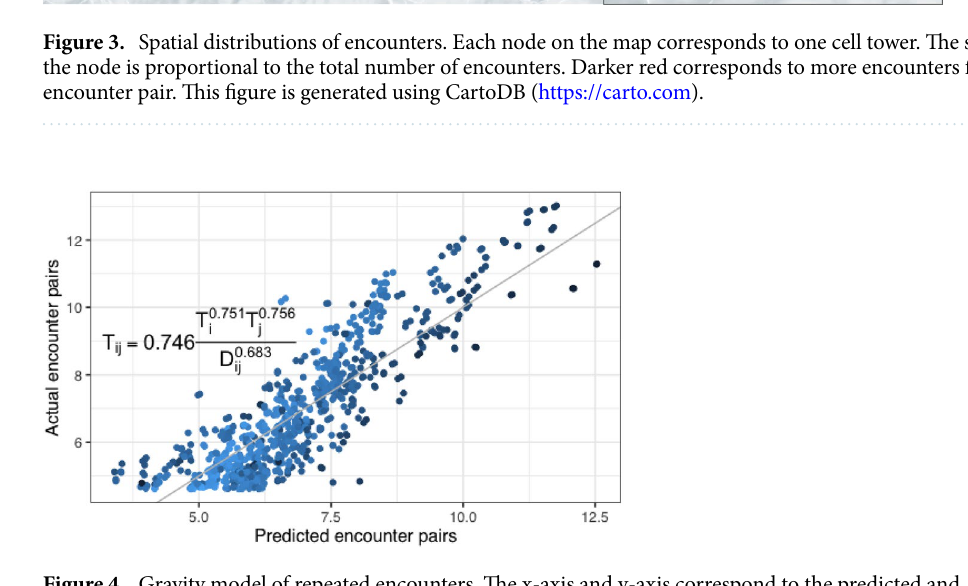
Figure 4. Gravity model of repeated encounters. The x-axis and y-axis correspond to the predicted and observed re-encounter pairs. The grey diagonal line represents perfect